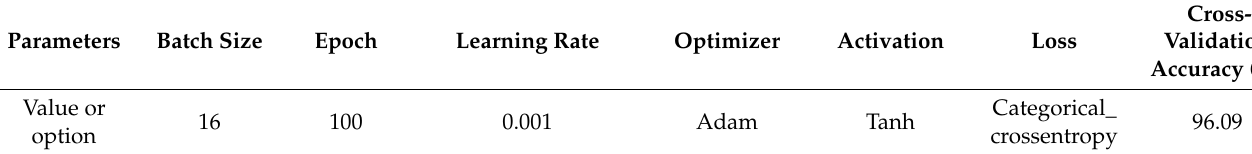
Table 3. Optimal parameters of the CNN model.